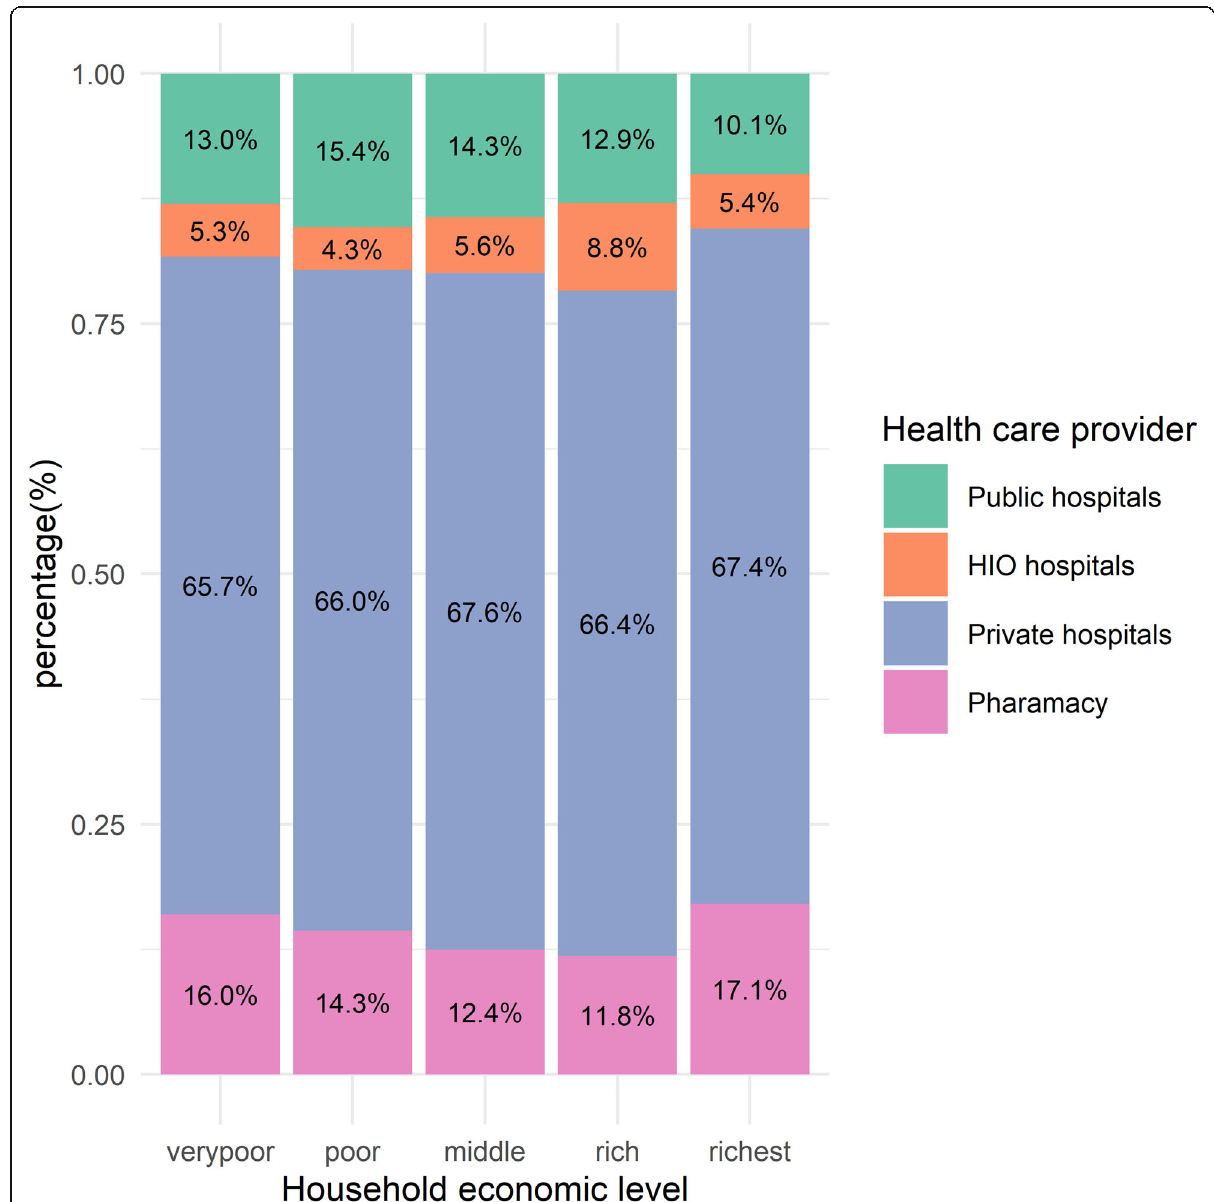
Fig. 2 Distribution of rural households by economic level and healthcare